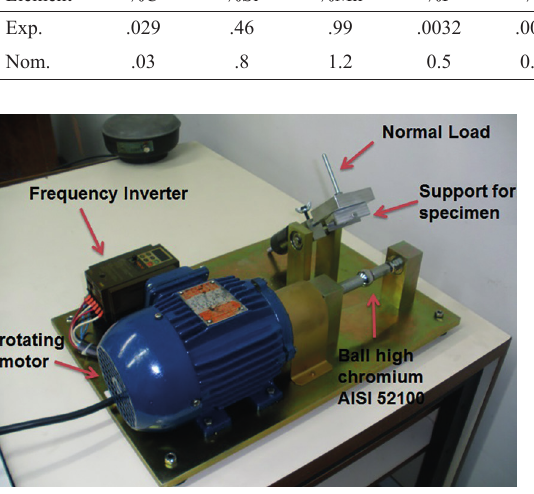
Table 1: Chemical composition (wt%) and nominal chemical composition of F-53 steel Element